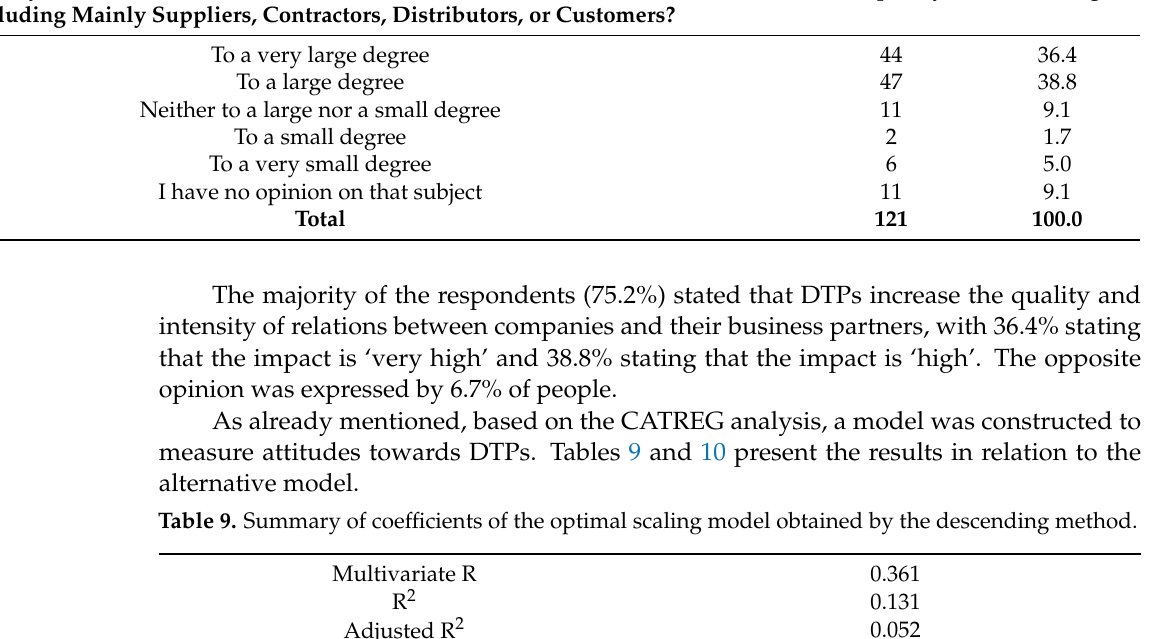
Table 10. ANOVA (analysis of variance) for the optimal scaling model obtained by the descending method. Sum of